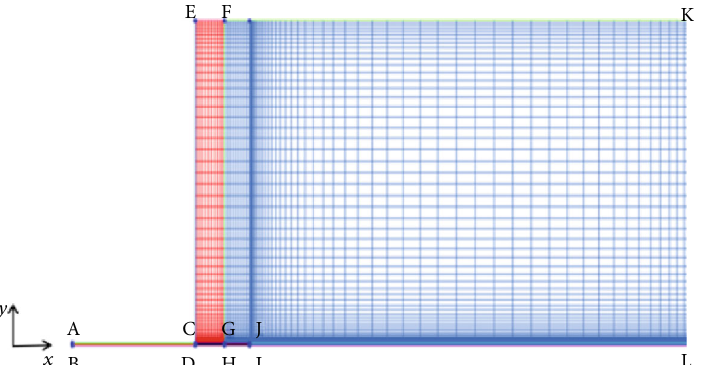
Figure 1: Model simpli fi ed schematic diagram.